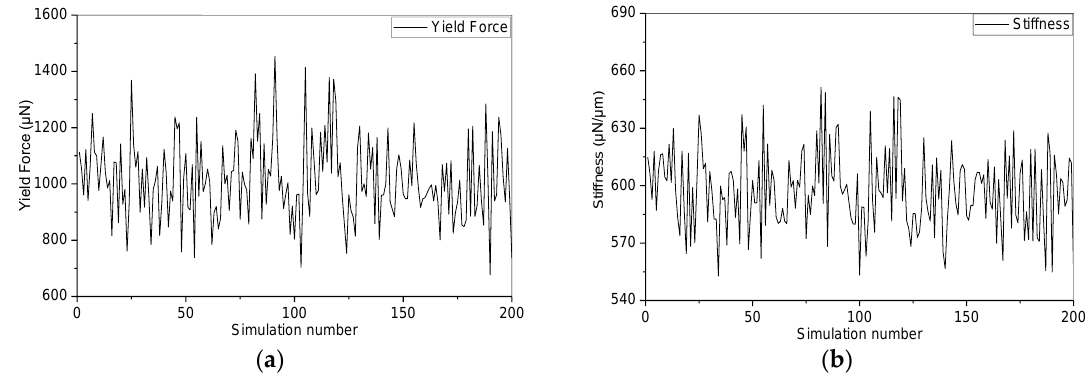
Figure 7. The yield force and stiffness for each simulation: ( a ) Yield force. ( b ) Stiffness. The statistical characteristic of the simulation-derived yield force and stiffness were analyzed. The probability density distribution curves of the fitted distributions of the yield force and stiffness are shown in Figure 8. A KS test was also carried out to inspect which distribution fitted the data best. It was found that the yield force and stiffness also complied with the Lognormal distribution best, where the KS statistic D were 0.035 and 0.042 for yield force and stiffness, respectively.